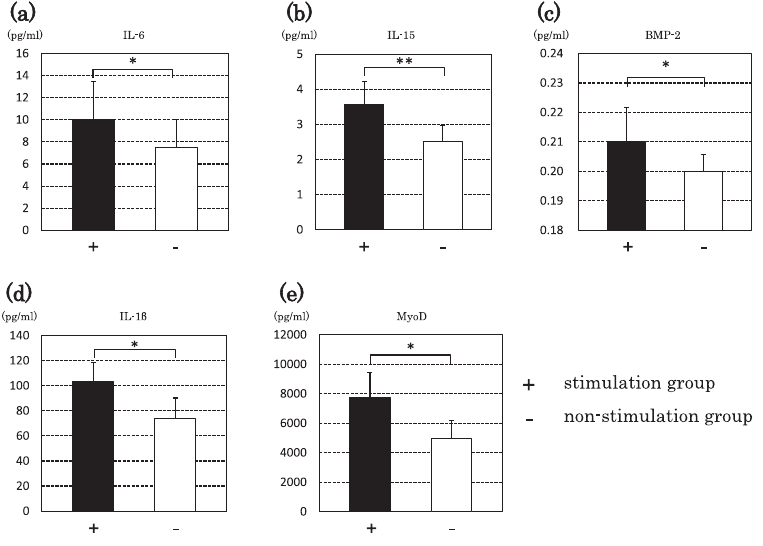
Figure 6 Protein expression in QFMs Graphs show ELISA results for (a) IL-6, (b) IL-15, (c) BMP-2, (d) IL-1 β and (e) MyoD. Black bars represent the stimulation group (+) and white bars represent the non-stimulation group (–). Significant differences were observed (**p<0.01,